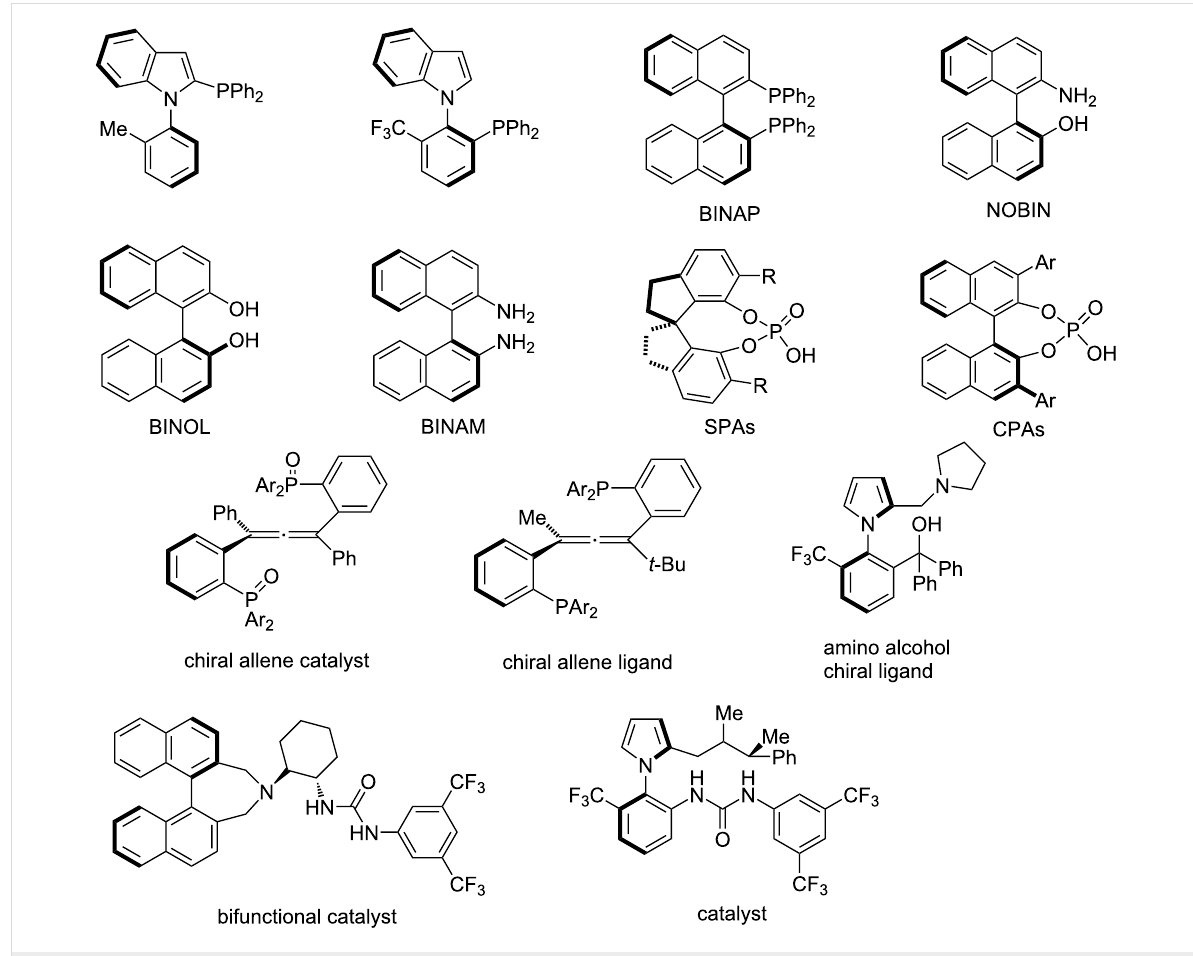
Figure 1: Representative examples of axially chiral biaryls, heterobiaryls, spiranes and allenes as ligands and catalysts.